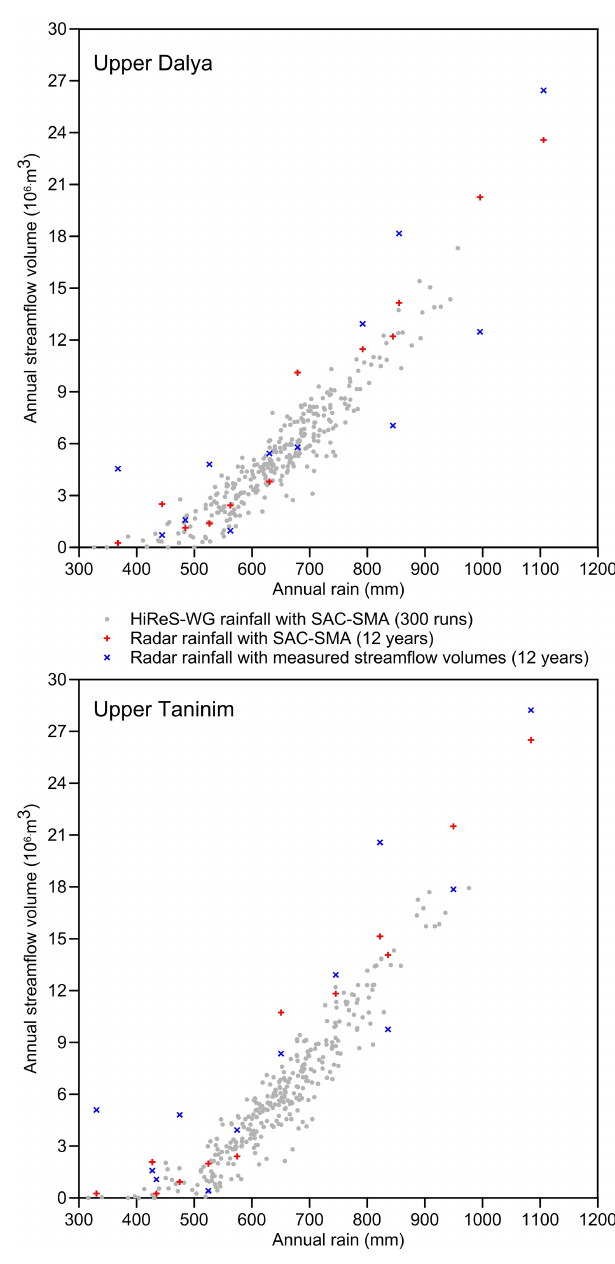
Figure 5. The annual streamflow volumes vs. the annual rainfall depth over the catchments. Three data samples are presented: ob- served rainfall from weather radar and observed volumes from hy- drometric stations (blue), observed rainfall from weather radar and simulated volumes from SAC-SMA (red) and rainfall realizations generated by the HiReS-WG and simulated volumes from SAC- SMA